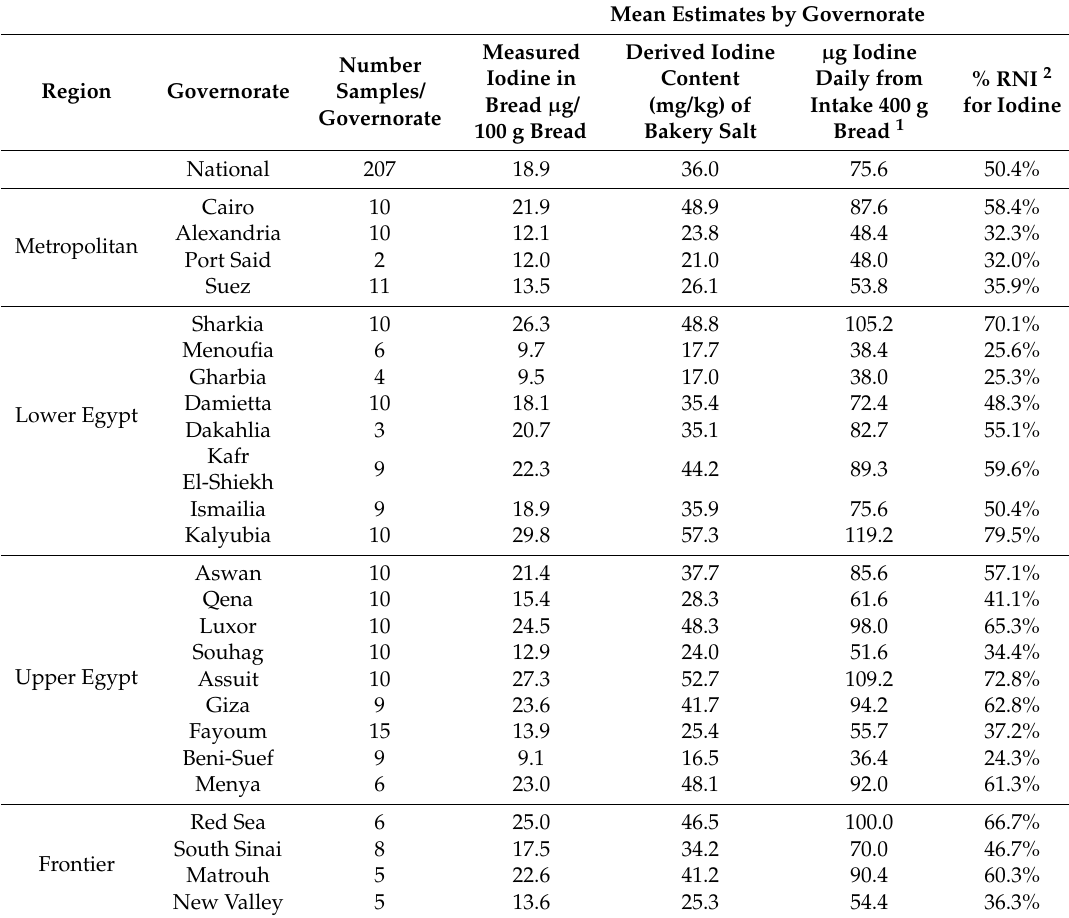
Mean Estimates by Governorate